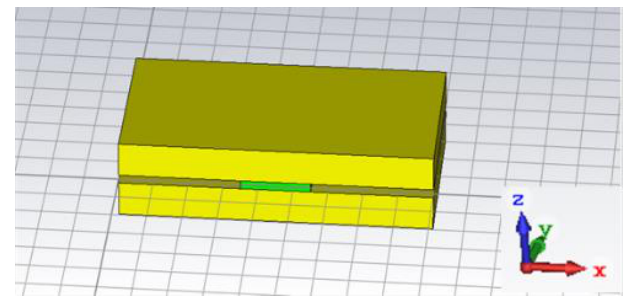
Figure 1. Simulation model of basic non-radiative dielectric (NRD) waveguide.